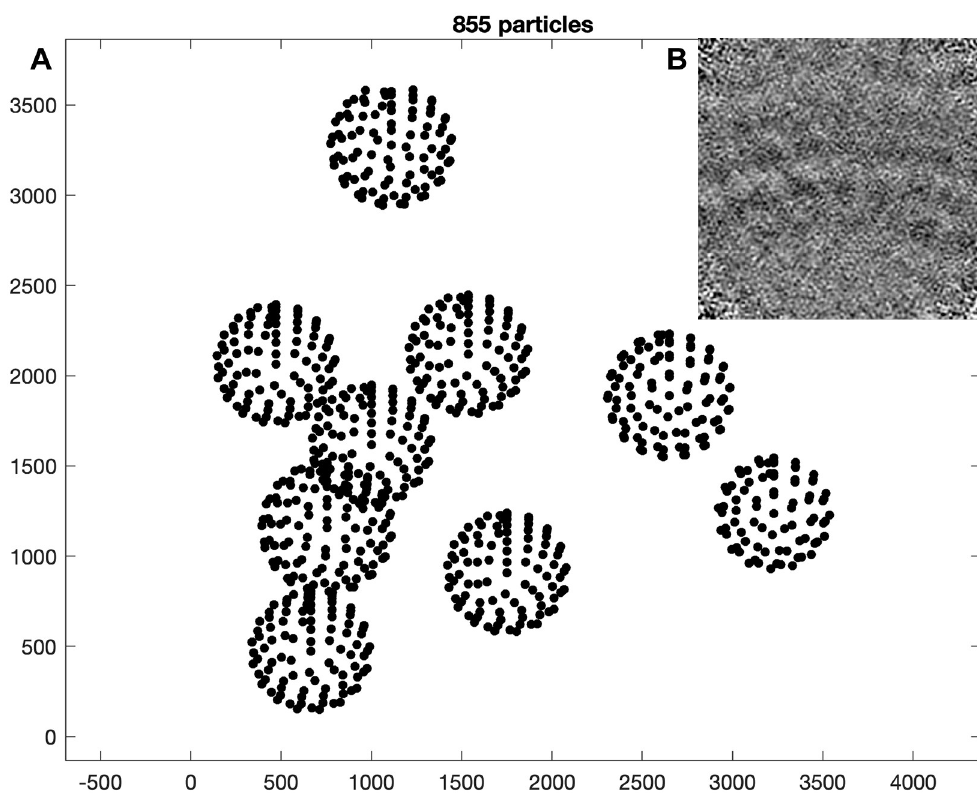
Fig 2. Oversampling of VLPs and average. (A) Crop points of tomogram ts001 (z-view) visualized with the Dynamo command dtplot. The crop points are located with a regular spacing on the surface of spheres. (B) Average of cropped particles (projected in x-view). The curvature of the VLP surface is visible. The data and commands to exactly reproduce this figure are available on EMPIAR (EMPIAR-10702). EMPIAR, Electron Microscopy Public Image Archive; VLP, virus- like